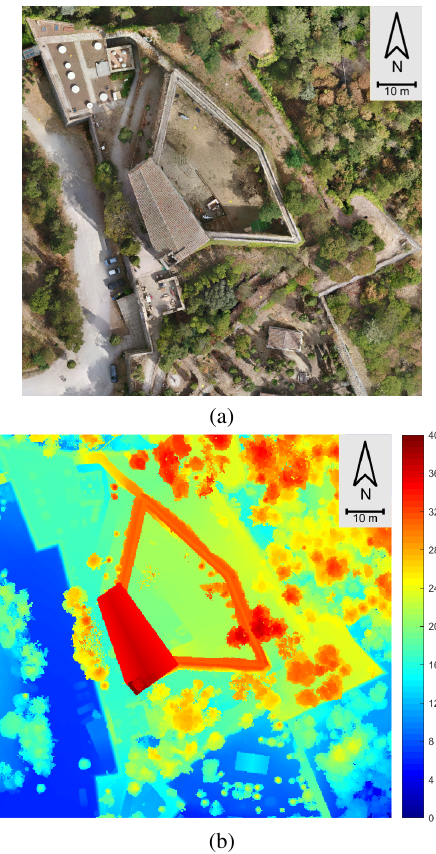
Figure 2. Orthophoto (a) and DEM (b) of the Girifalco